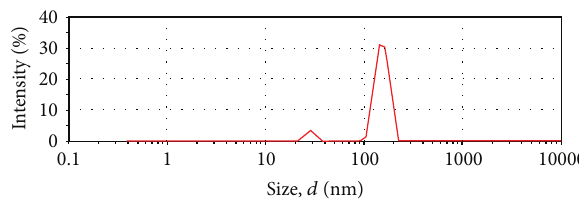
Figure 6: Size distribution of TFT-LCD